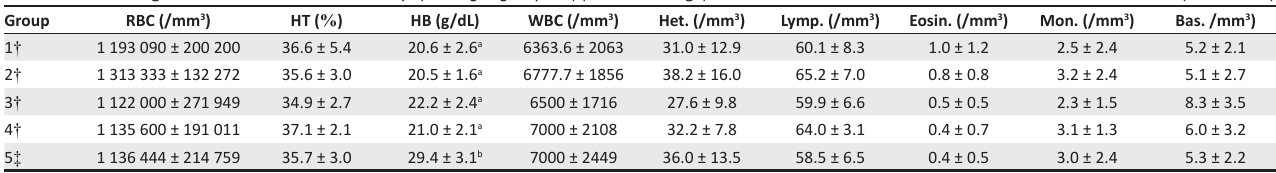
TABLE 3: Haematological values in female bronze turkeys ( Meleagris gallopavo ) (36 weeks of age) vaccinated with various commercial strains of Newcastle disease (mean ± s.d.). Group RBC (/mm 3 ) HT ( % ) HB (g/dL)